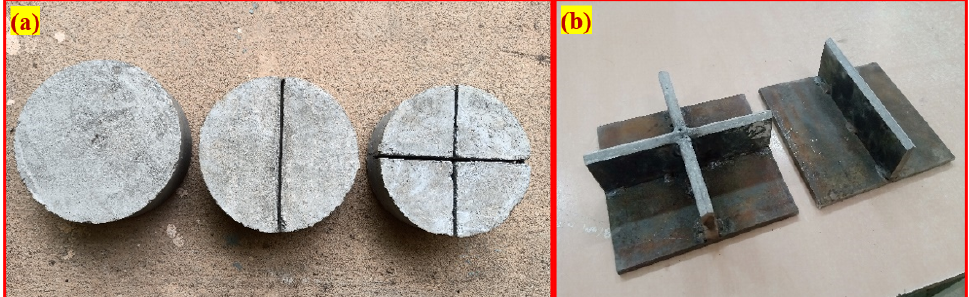
Figure 2. Modification details ( a ) specimens with and without notch ( b ) load transfer plates.